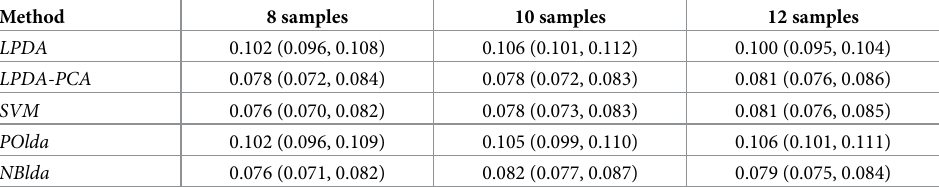
Table 2. Classification error test average and confidence interval in cervical cancer